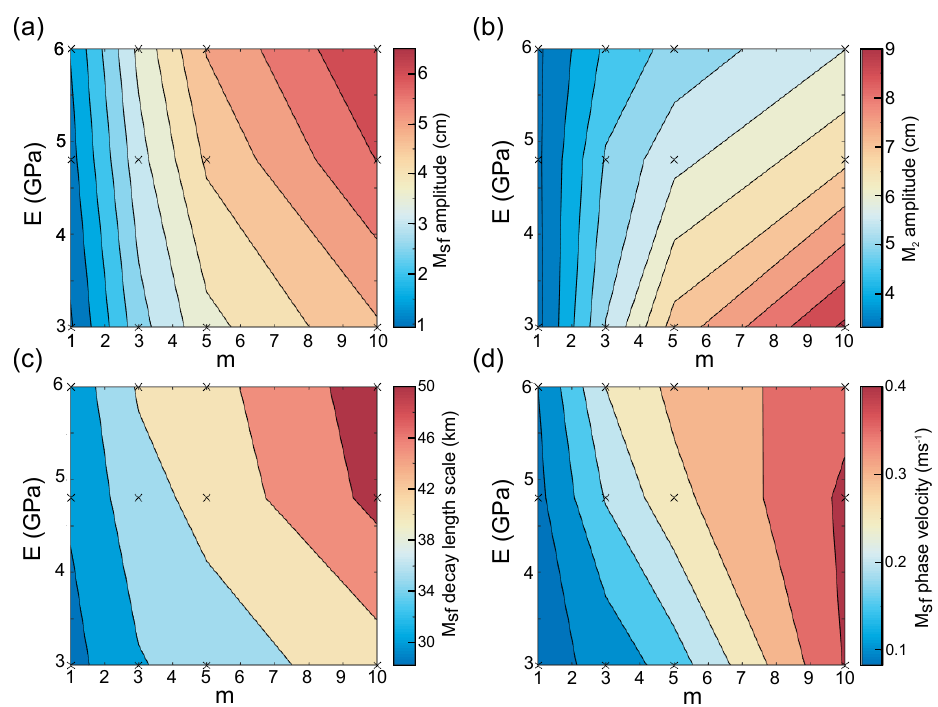
Figure 4. Modelled M sf and M 2 tidal amplitudes 10km upstream from the grounding line ( a and b , respectively), and M sf decay length scales and phase velocities ( c and d , respectively) as a function of the basal sliding law stress exponent m and the elastic Young’s modulus ( E ) of ice. Here the potential effects of subglacial water pressure variations in response to tides on sliding were not included, i.e. in the sliding law (Eq. 8), q = 0. Crosses indicate model simulations. The contour plot is based on interpolation of model results. M sf and M 2 amplitudes were taken at 10km upstream from the grounding